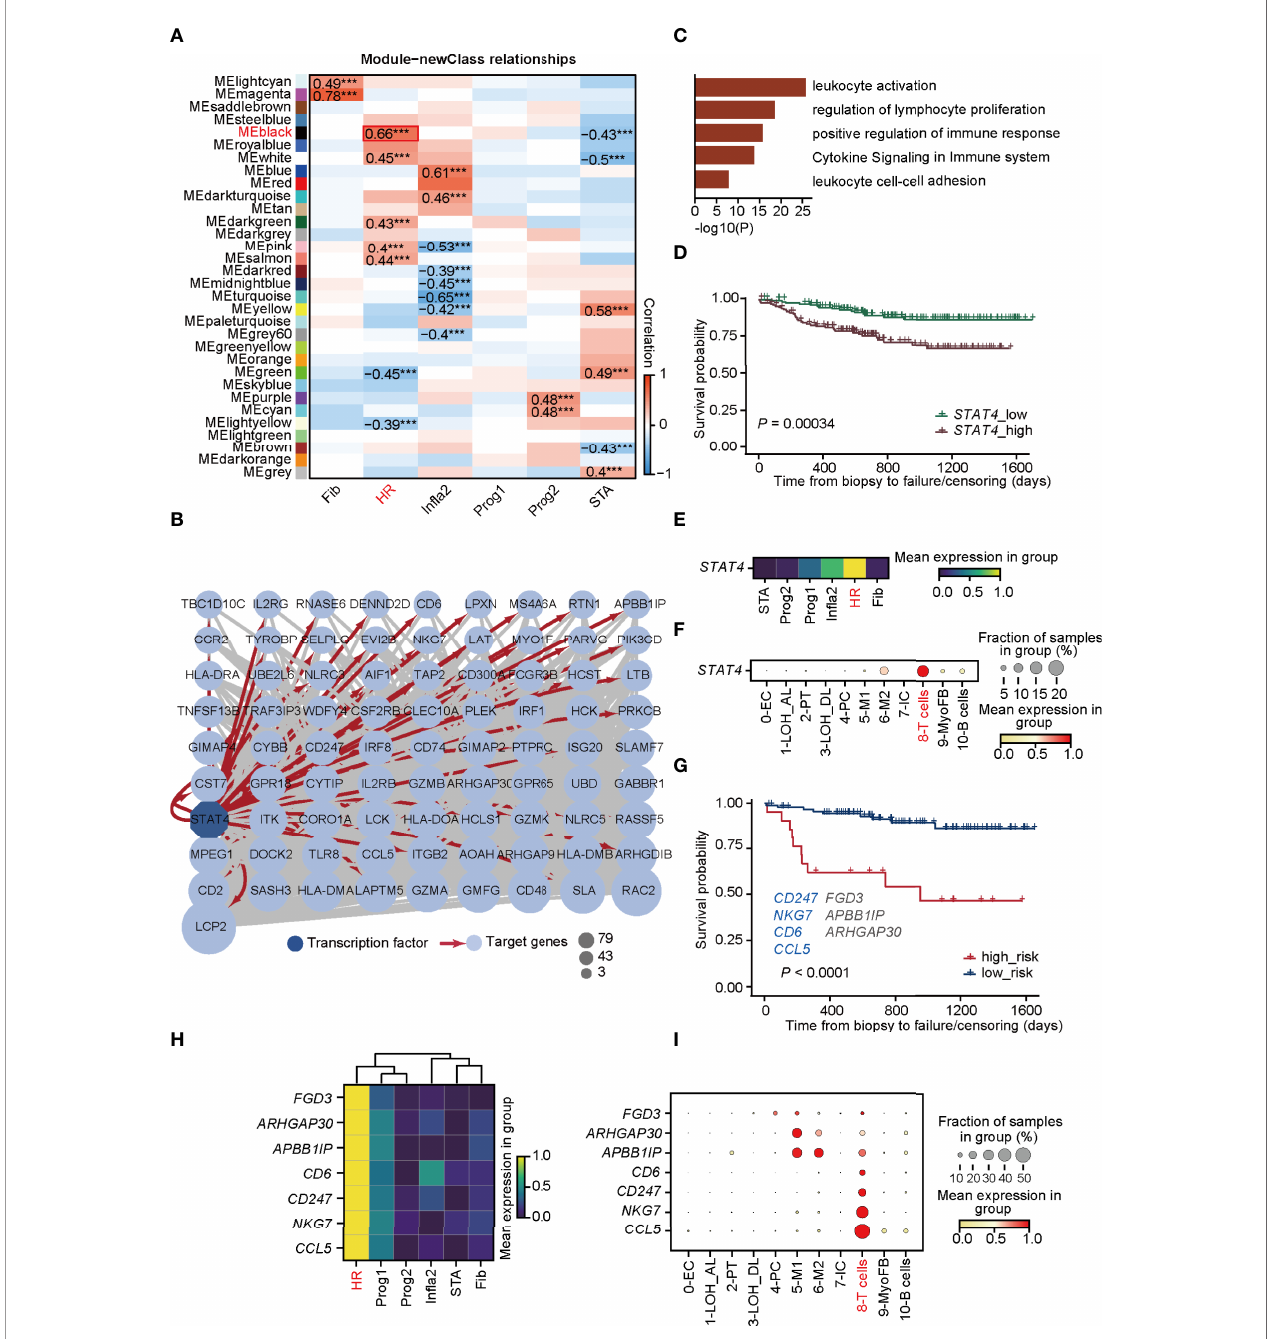
FIGURE 3 | STAT4 is essential in mediating T-cell immune responses towards HR rejection. (A) Heatmap presenting the 31 clusters of HVGs and the correlation between gene modules and rejection states. *** p -value < 0.001. (B) Visualization of co-expression network and hub genes regulated by STAT4 from MEblack module in HR. Dark blue- fi lled octagonal nodes: transcription factors; light blue- fi lled circular nodes: target genes; red lines with arrows: regulatory relationship; node size: degree of transcription factor-target connectivity. (C) The enriched Gene Ontology terms for STAT4 and its downstream regulatory genes. (D) The survival curves for STAT4 in patients with renal transplantation rejection. (E) Matrix plot showing the expression level of STAT4 in various rejection states. (F) The expression of transcription factor STAT4 in various cell types. (G) The survival curve of validation cohorts with predicted high and low risk of graft failure. Genes marked in blue are known to be relevant to graft rejection and those in gray were newly identi fi ed. (H) Matrix plot showing the expression level of optimal genes in rejection states. (I) The expression of the optimal genes in various cell types. LOH_AL, loop of Henle, ascending limb; LOH_DL, loop of Henle, distal limb; Endo, endothelial cell; PT, proximal tubule; PC, principal cell; MyoFB, myo fi broblast; IC, intercalated cell. HR, high-risk state; Prog1, progressive state 1; Prog2, progressive state2; In fl a2, in fl ammatory state 2; STA, stable state; Fib, fi brosis